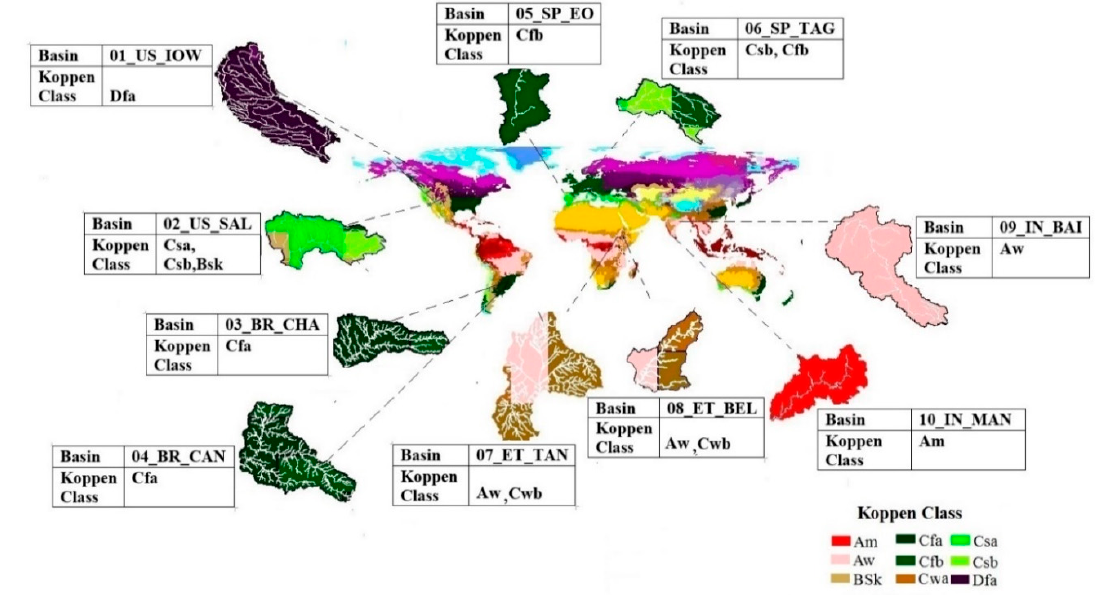
Figure 1. Koppen classification of the world and the location of the watersheds used in this study along with their characteristics.